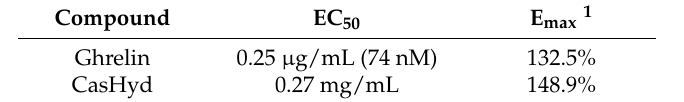
Figure 1. ( A ) Concentration response curve of casein-derived hydrolysate. Concentration response curve for the casein-derived hydrolysate, CasHyd, measured in growth hormone secretagogue receptor-type 1a (GHSR-1a) overexpressed in HEK293A cells; ( B ) Activity of CasHyd in wild-type (HEK293A-WT) cells, 5HT 2C receptor (HEK293A-5HTR 2C ) and a fully edited form of 5HTR 2C (HEK293A-5HTR 2C -VSV) expressing cells. Intracellular Ca 2+ increase is depicted as a percentage of maximal Ca 2+ influx in relative fluorescence units (RFU) as elicited by control (3.3% fetal bovine serum; FBS). The parent casein protein elicited negligible effects on all cell lines. Graphs represent mean ± SEM (standard error of the mean) of at least three independent experiments performed in triplicate. Table 1. Activity of CasHyd and Ghrelin on GHSR-1a overexpressing HEK293A cells.